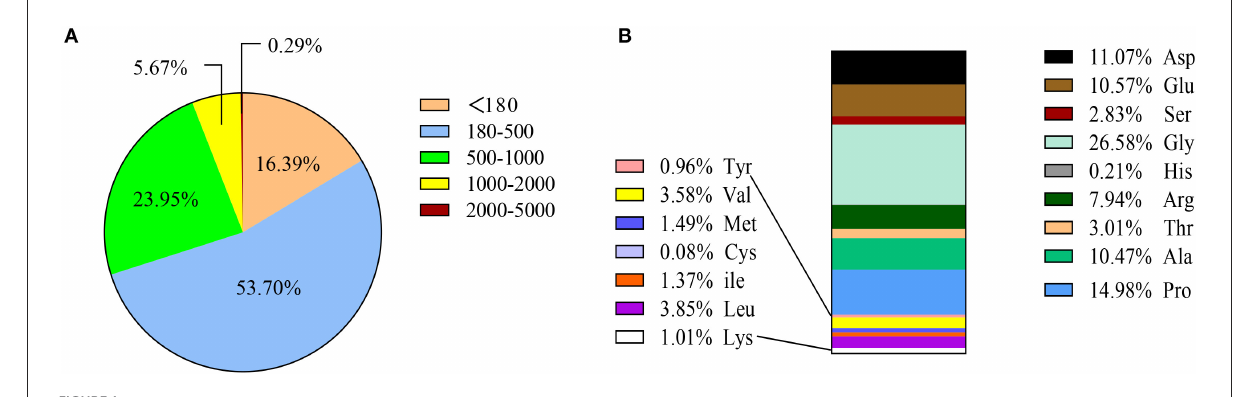
with the Tukey-Kramer test or t -test was carried out to detect the statistical significance with a significant level of α = 0.05